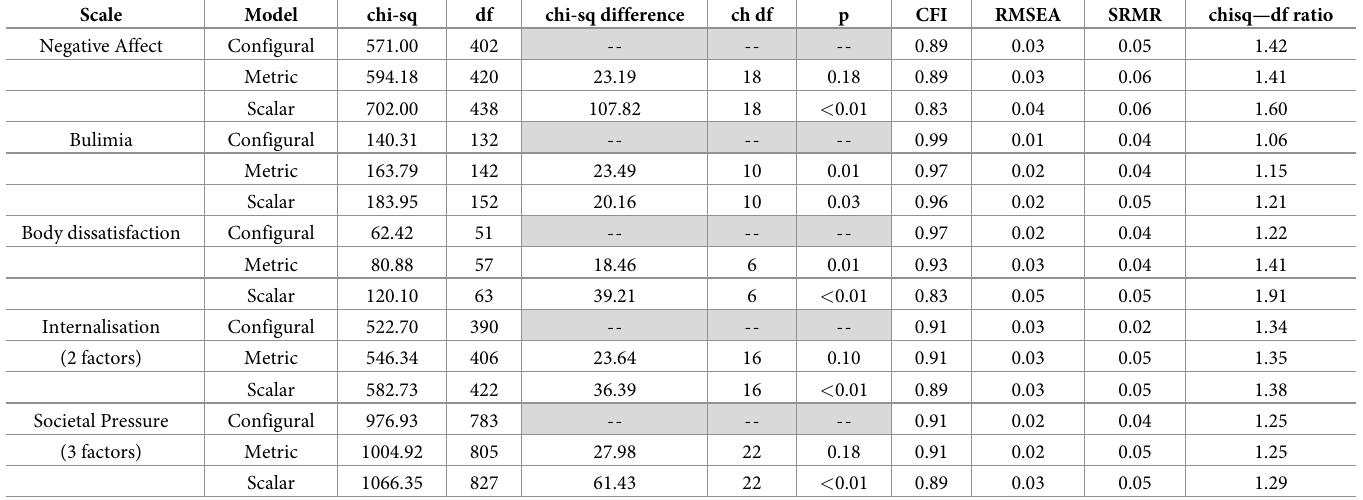
Table 4. Confirmatory factor